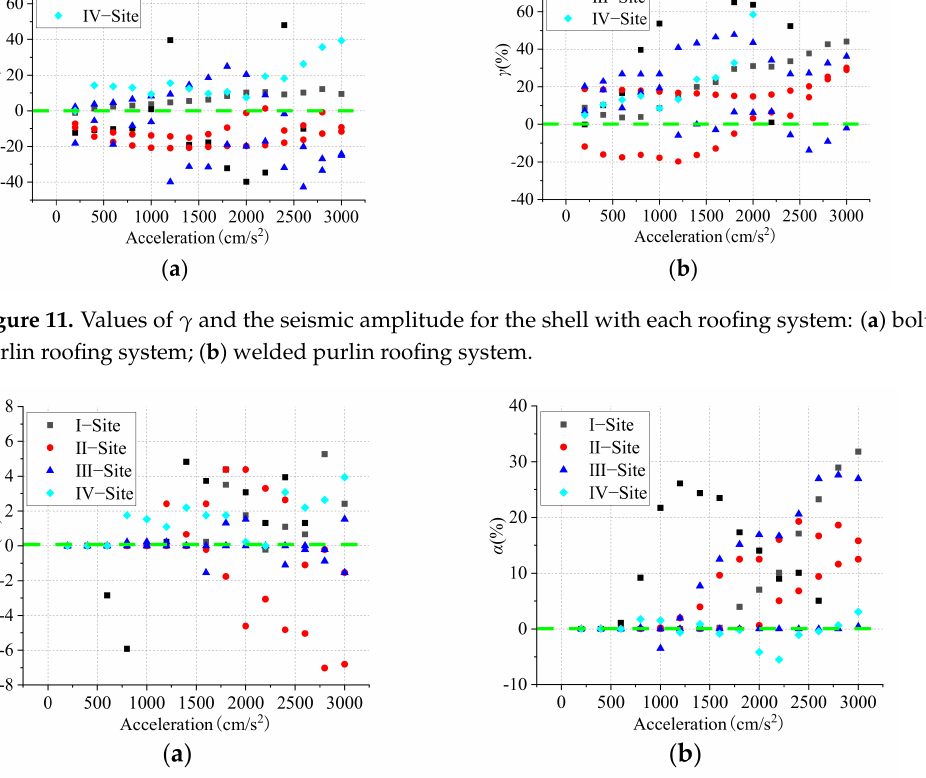
Figure 12. Values of α and the seismic amplitude for the shell with each roofing system: ( a ) bolted purlin roofing system; ( b ) welded purlin roofing